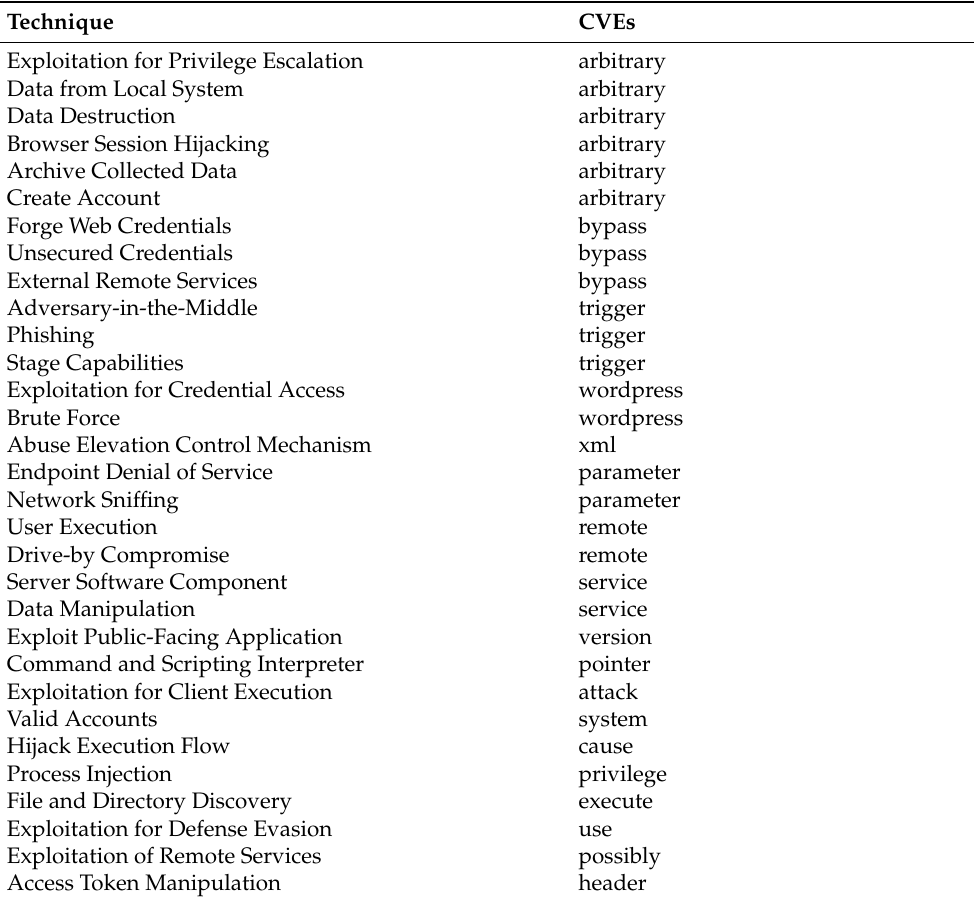
Figure 12. Comparison of word mappings for each technique corresponding to CVE #5 from Table 4. ( a ) Mapping Exploitation for Client Execution; ( b ) Mapping Endpoint Denial of Service. Table 5. The most important words extracted per